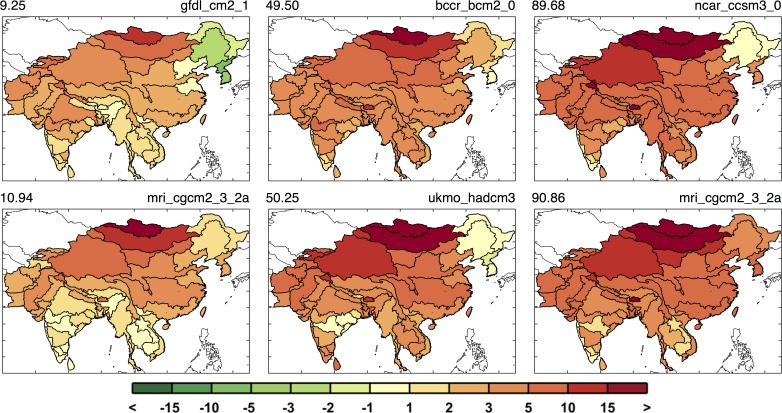
Irrigation requirement change patterns (in %) around the 10th, 50th, and 90th percentile, two each based on the mean irrigation requirement change for the region.Top label shows the percentile (left) and GCM name (right.)